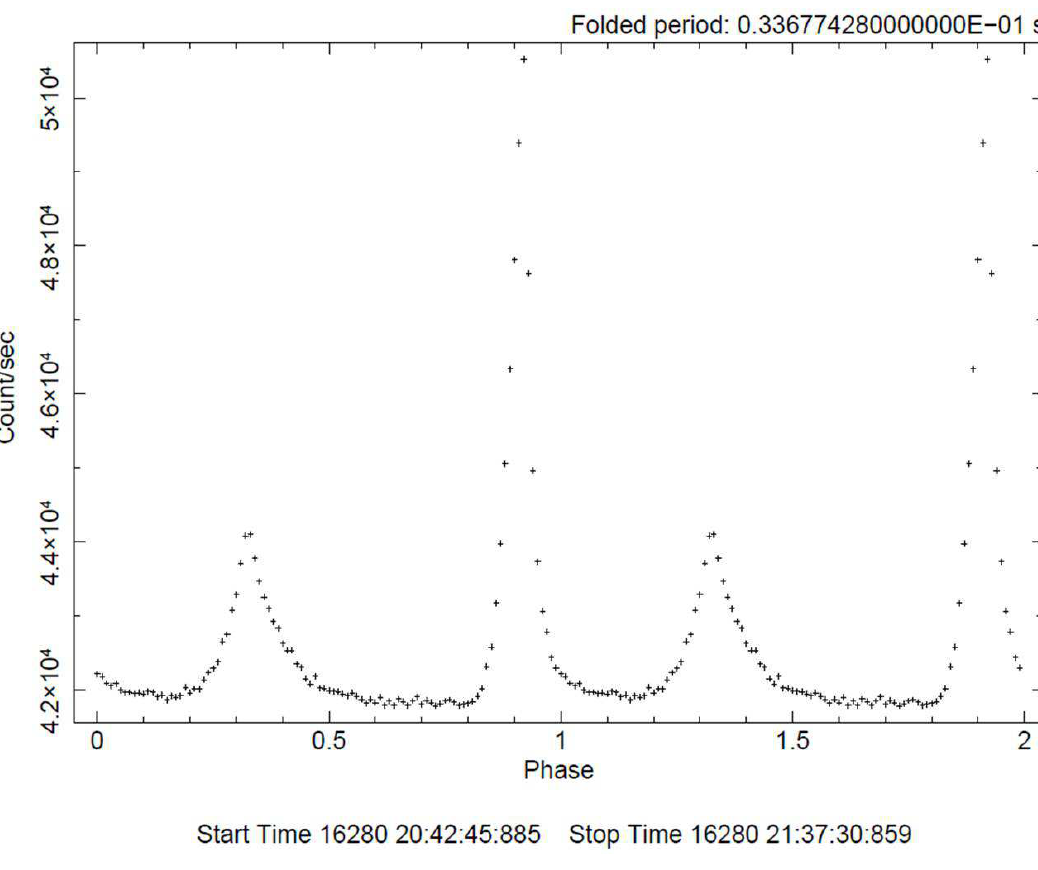
Figure 4: Crab pulsar light curve folded by the Xronos task efold for P3E0 (2012, December 19) corrected